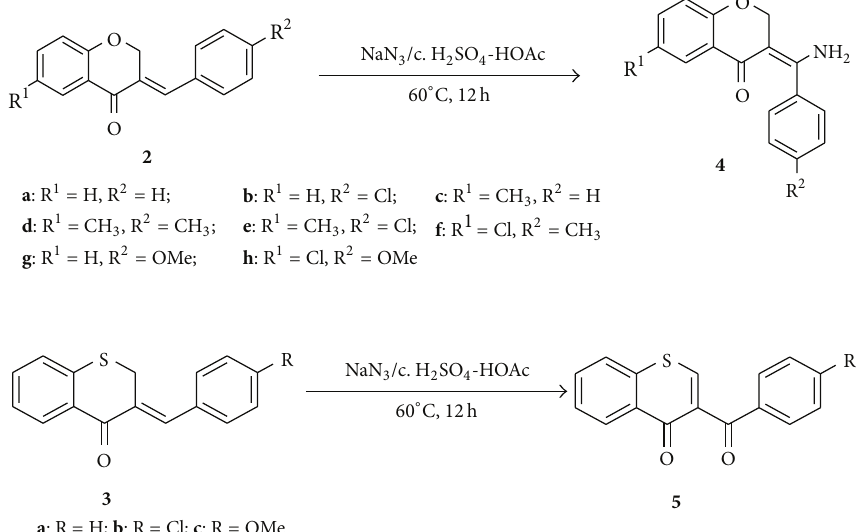
Scheme 1: Schmidt reaction of E -3-benzylidenechromanones ( 2 ) and E -3-benzylidenethiochromanones ( 3 ).